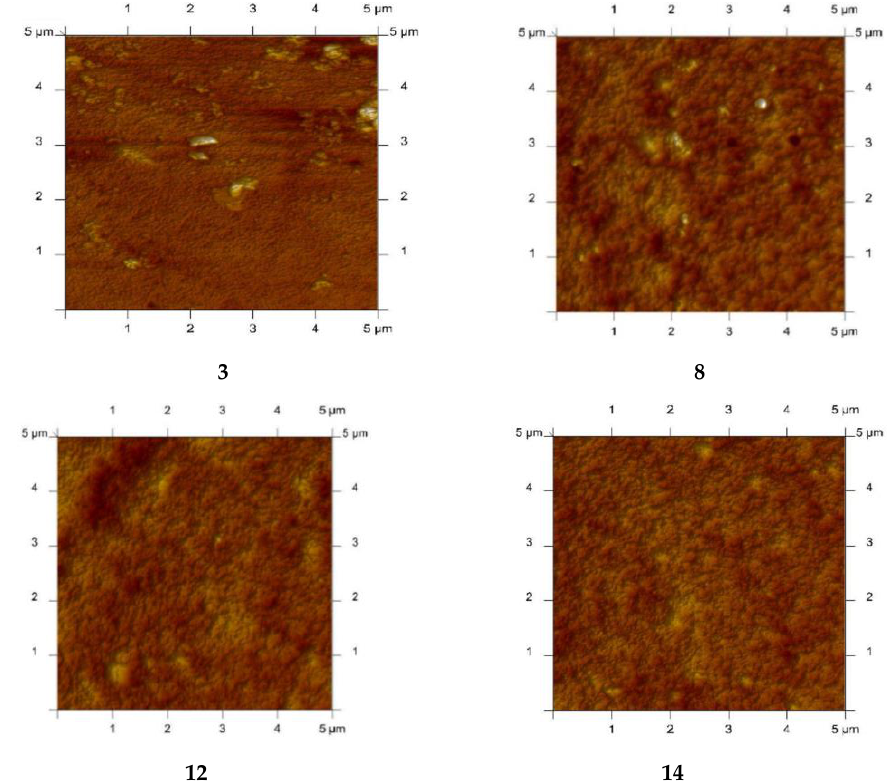
Figure 10. 2D-view atomic force micrographs of PIMs with 1-octylimidazole ( 3 ), 1-octyl-2-methylimidazole ( 8 ), 1-octyl-4-methylimidazole ( 12 ), and 1-octyl-2,4-dimethylimidazole ( 14 ), [61].